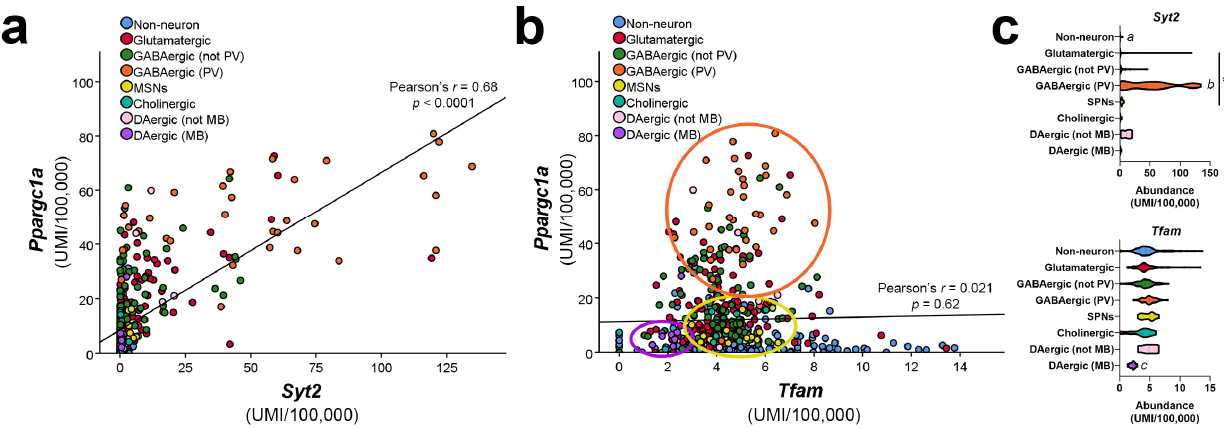
Figure 2. ( a ) Ppargc1a and synaptotagmin 2 (Syt2) or ( b ) Ppargc1a and Tfam mRNA expression is compared in different cell types using publicly available single-cell transcriptomic profiles [64]. Circles indicate clustering of datapoints for parvalbumin-positive interneurons (orange), spiny projection neurons (yellow), or dopaminergic neurons of the midbrain (purple). ( c ) Abundance of mRNA for Syt2 and Tfam by cell type. Two-tailed correlation analyses were used in (a,b), and Kruskal-Wallis analysis was used in (c), with * p < 0.05, and letters indicating other statistically significant differences <0.05. a = different than all but cholinergic and DAergic (MB); b = different than all but DAergic (MB); c = different than all but cholinergic. UMI = unique molecular identifier. PV = parvalbumin-expressing neurons. SPNs = spiny projection neurons. MB = midbrain.